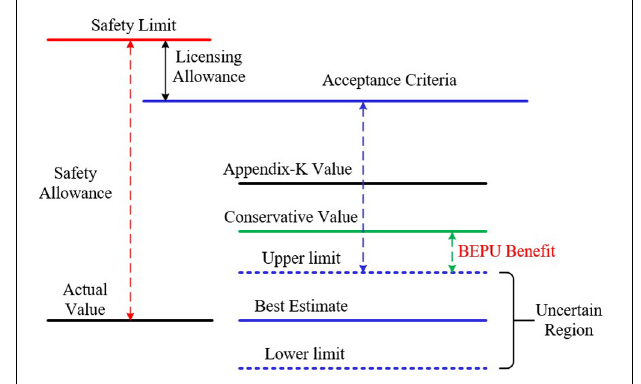
FIGURE 1 | Comparison of safety margins in evaluating different